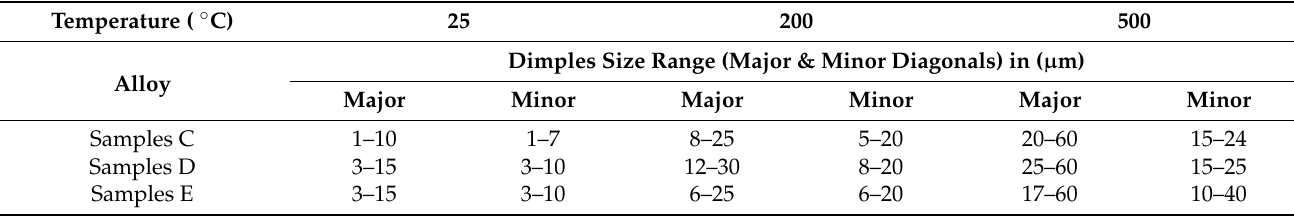
Table 5. The range of dimple lengths in different DMLS Ti6Al4V(ELI) samples fractured at a strain rate of 2450 s − 1 and at different